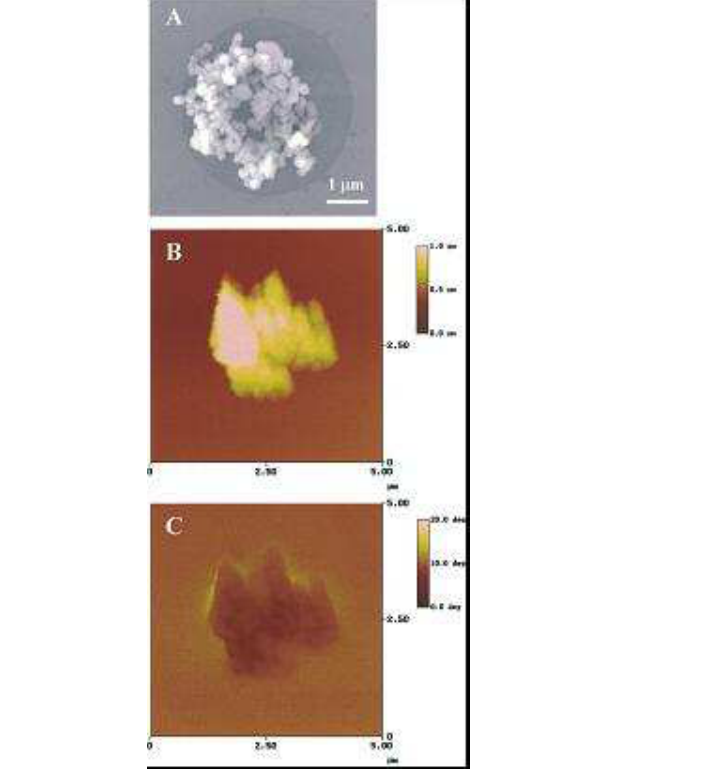
Figure 10. SEM (A), AFM (B) and MFM (C) images of magnetic microbeads immobilized on a patterned substrate by specific interaction between biotin and streptavidin. Dot size = 4µm ( Reprinted from [25] with permission from Wiley-VCH